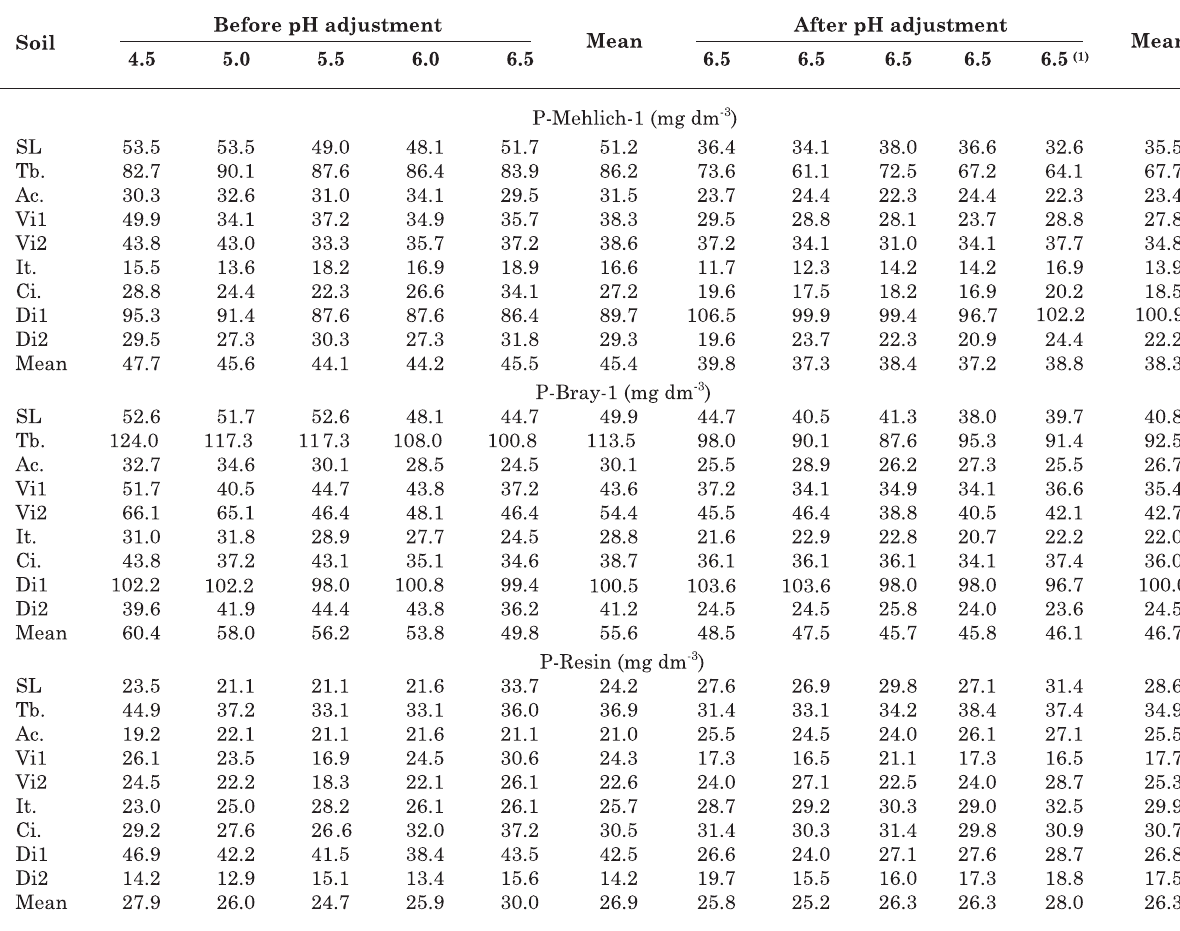
Table 8. Phosphorus content in soil as determined by the extractants Mehlich-1, Bray-1 and Resin, before and after the adjustment of different pH values to 6.5